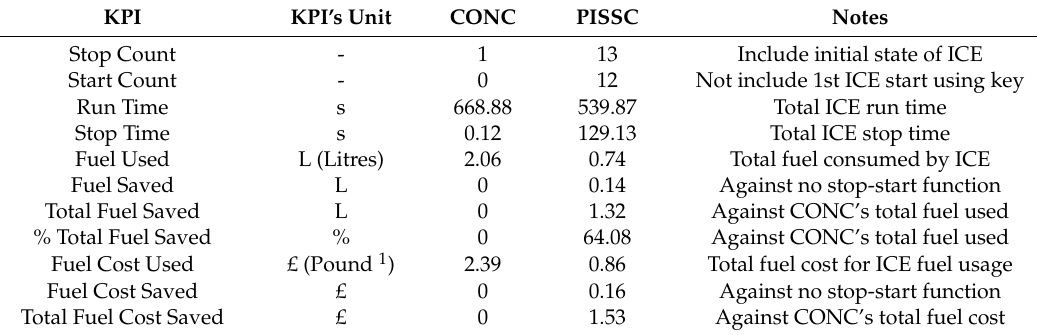
Table 6. KPI analysis for the simulated ICE performances during the first 06 working cycles. KPI KPI’s Unit